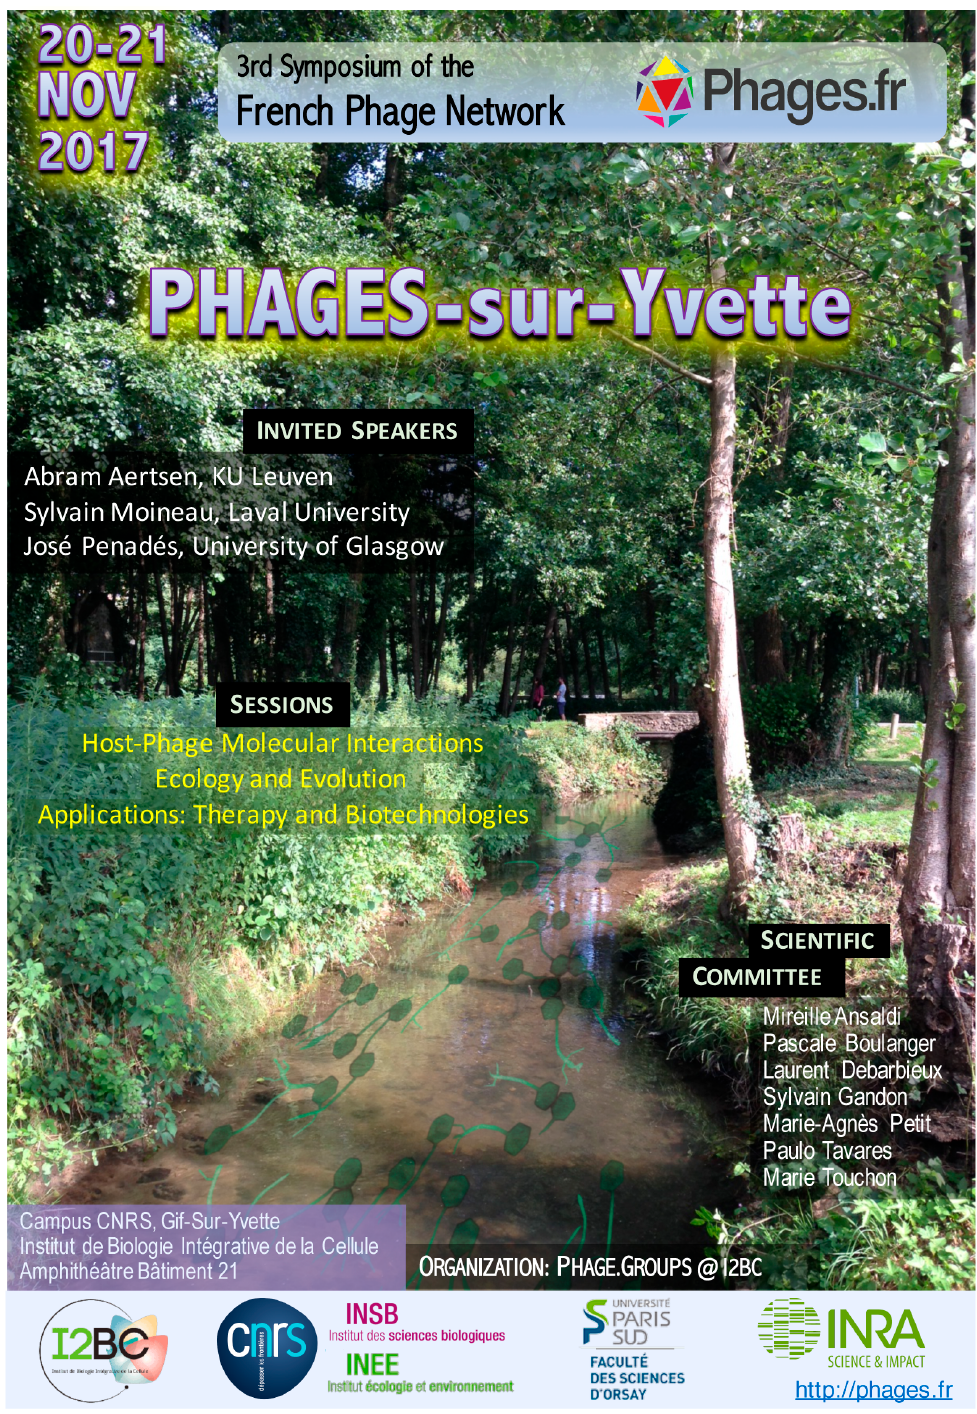
Figure 1. Poster of the third meeting of the French Phage Network.